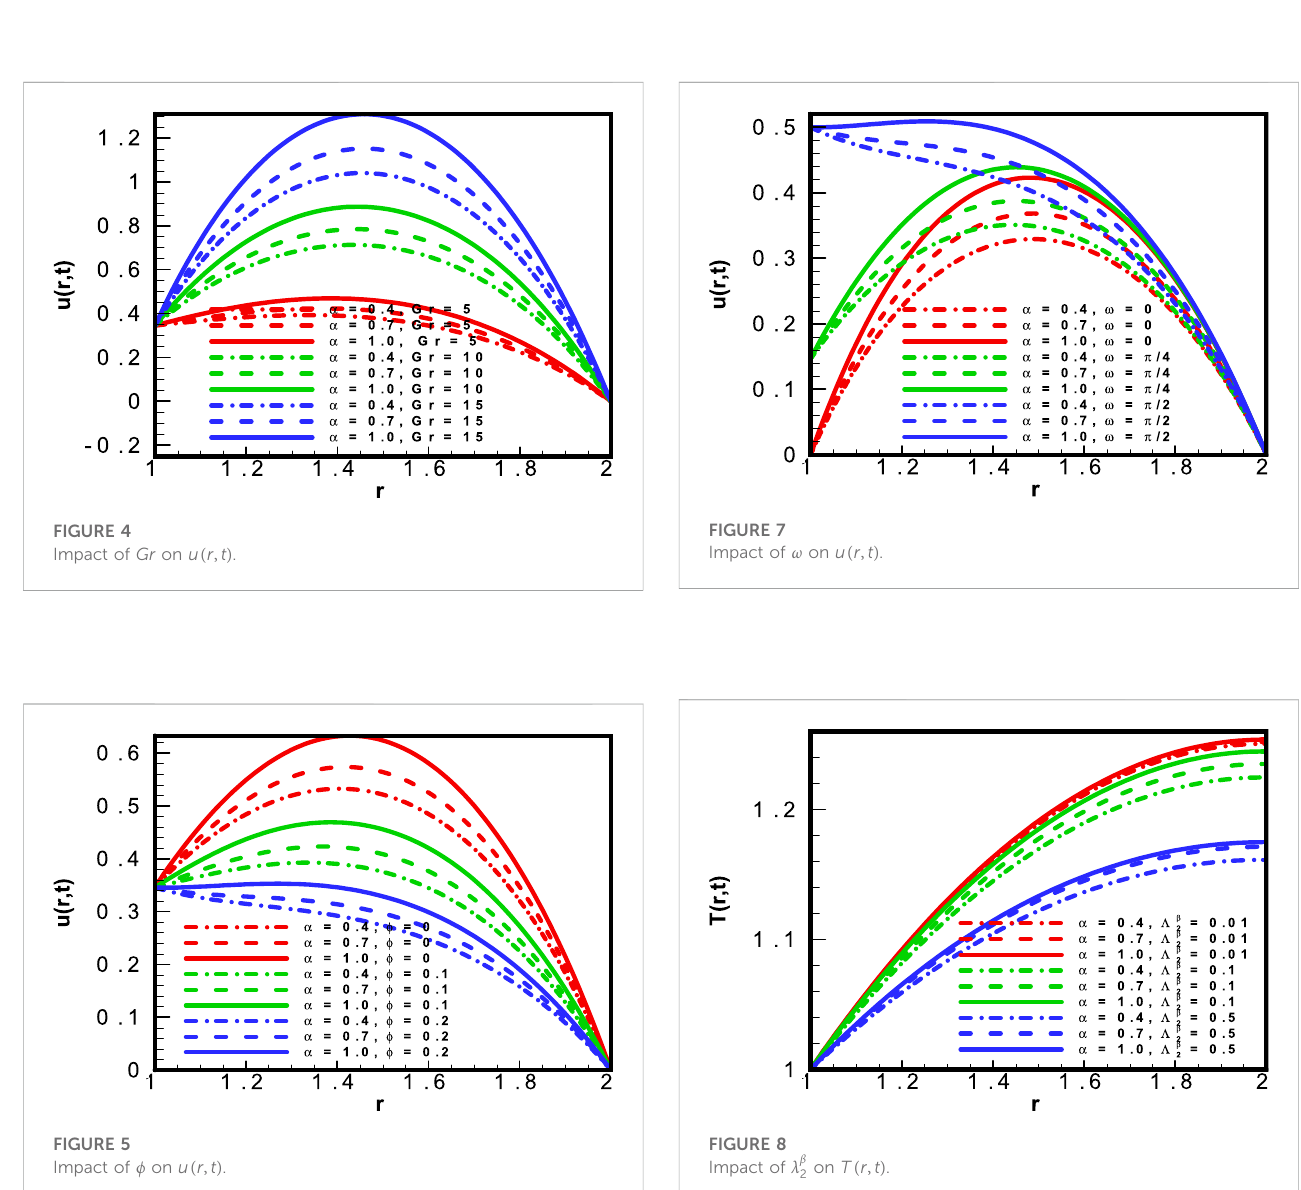
FIGURE 5 Impact of ϕ on u ( r , t ) .